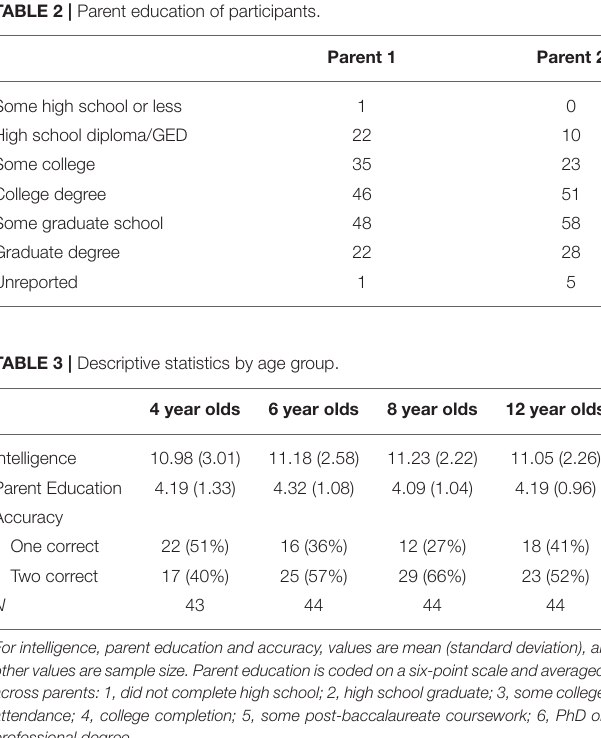
TABLE 2 | Parent education of participants.